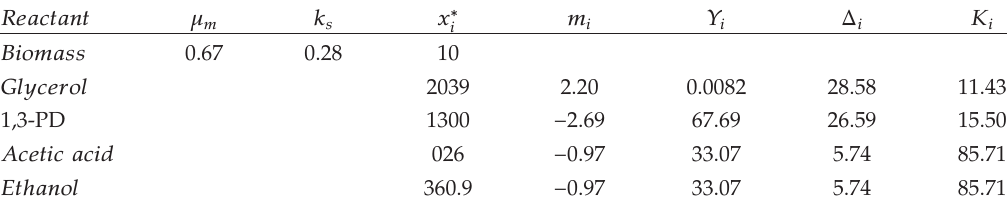
Table 2: Parameters values of each reactant in the impulsive switching